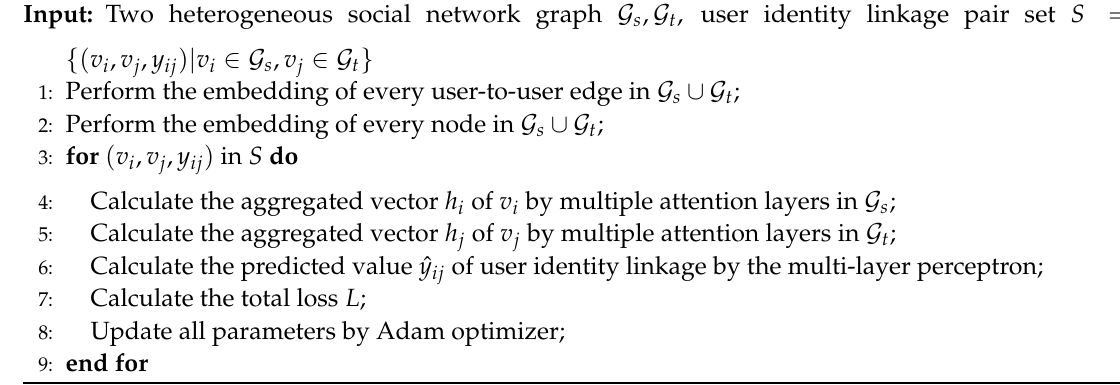
Algorithm 1 Model training